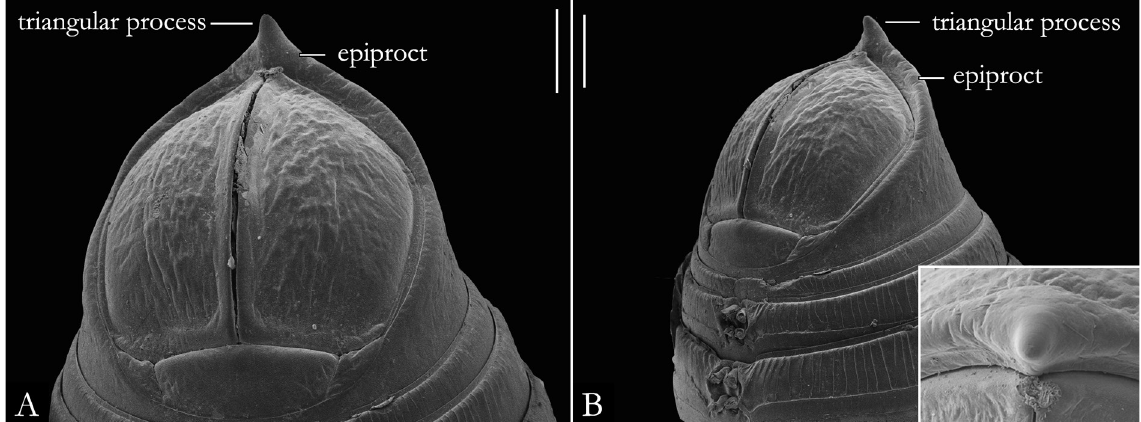
Fig. 54. Pseudonannolene buhrnheimi Schubart, 1960, ♀ (IBSP 2397), posterior region. A . Ventral view. B . Lateral view. Detail of epiproct with triangular process. Scale bars = 0.25